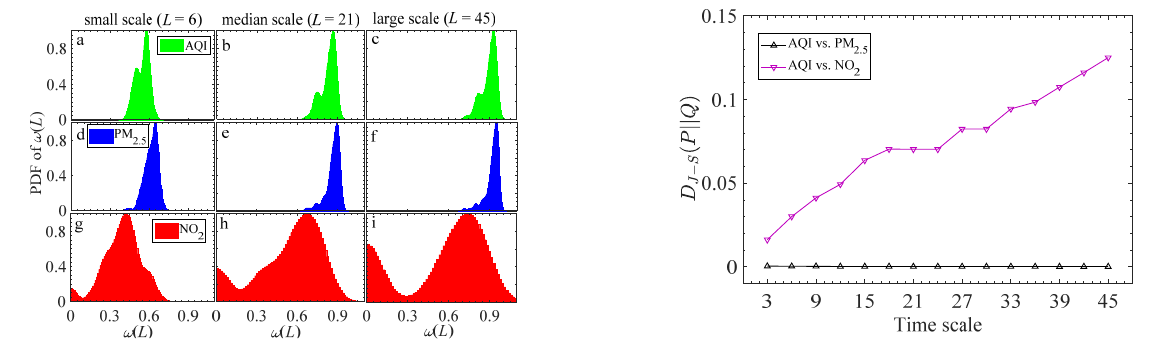
Figure 2. The left panel is the PDF of scale ‐ dependent edge weights for three indexes of AQI, PM 2.5 , and NO 2 at three given time scales, namely, small scale (a, d, g), median scale (b, e, h) and large scale (c, f, i). There is a similar shape of the PDF between the AQI and PM 2.5 , while a significant difference can be observed between them and that of NO 2 . The right panel is the J ‐ S divergence of the edge weight of AQI’s network and that of the two pollutants’ networks with respect to different time scales.